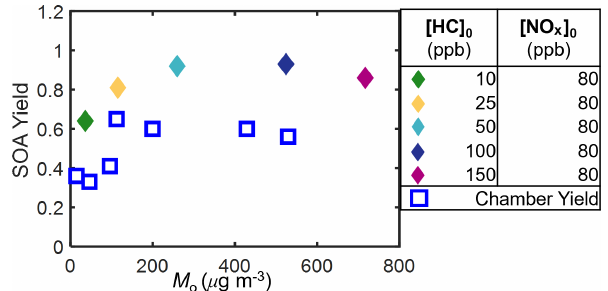
Figure 9. Predicted SOA mass yields based on GECKO-A model simulations.